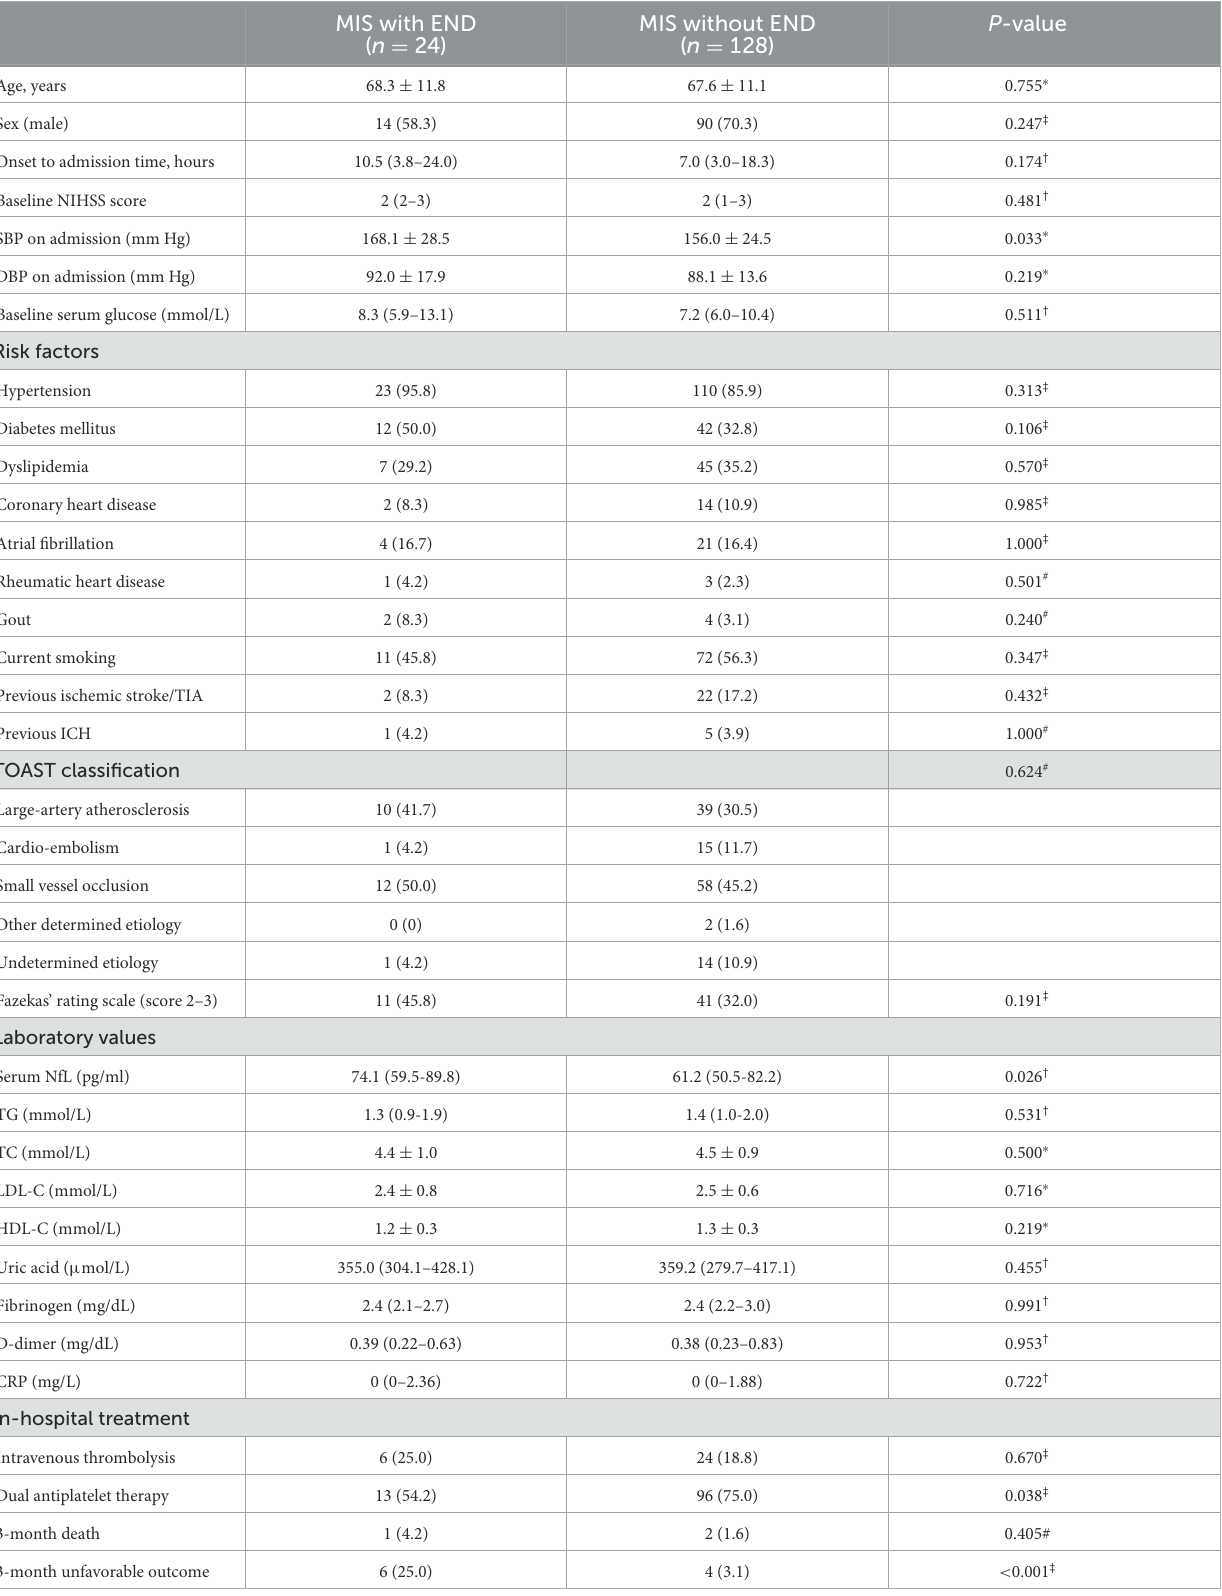
TABLE 2 Baseline characteristics and clinical outcomes between patients with MIS with and without END. MIS with END ( n =